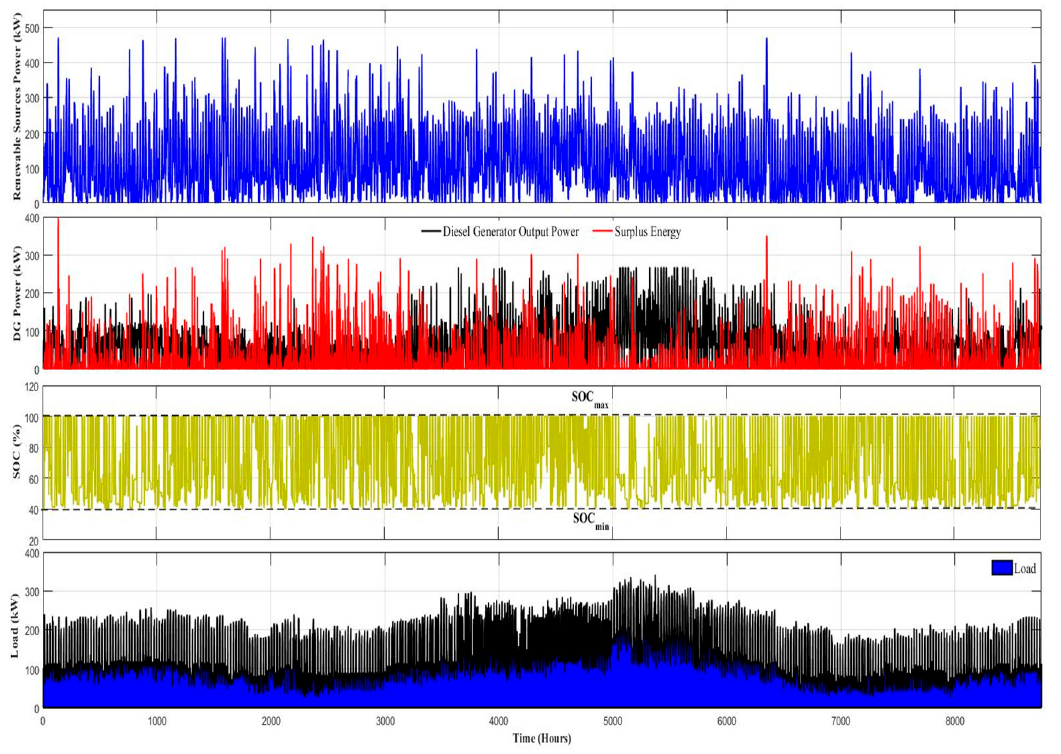
Figure 14. The HES performance related to renewable sources power, surplus power, diesel generator power, battery bank SOC and the load profile.